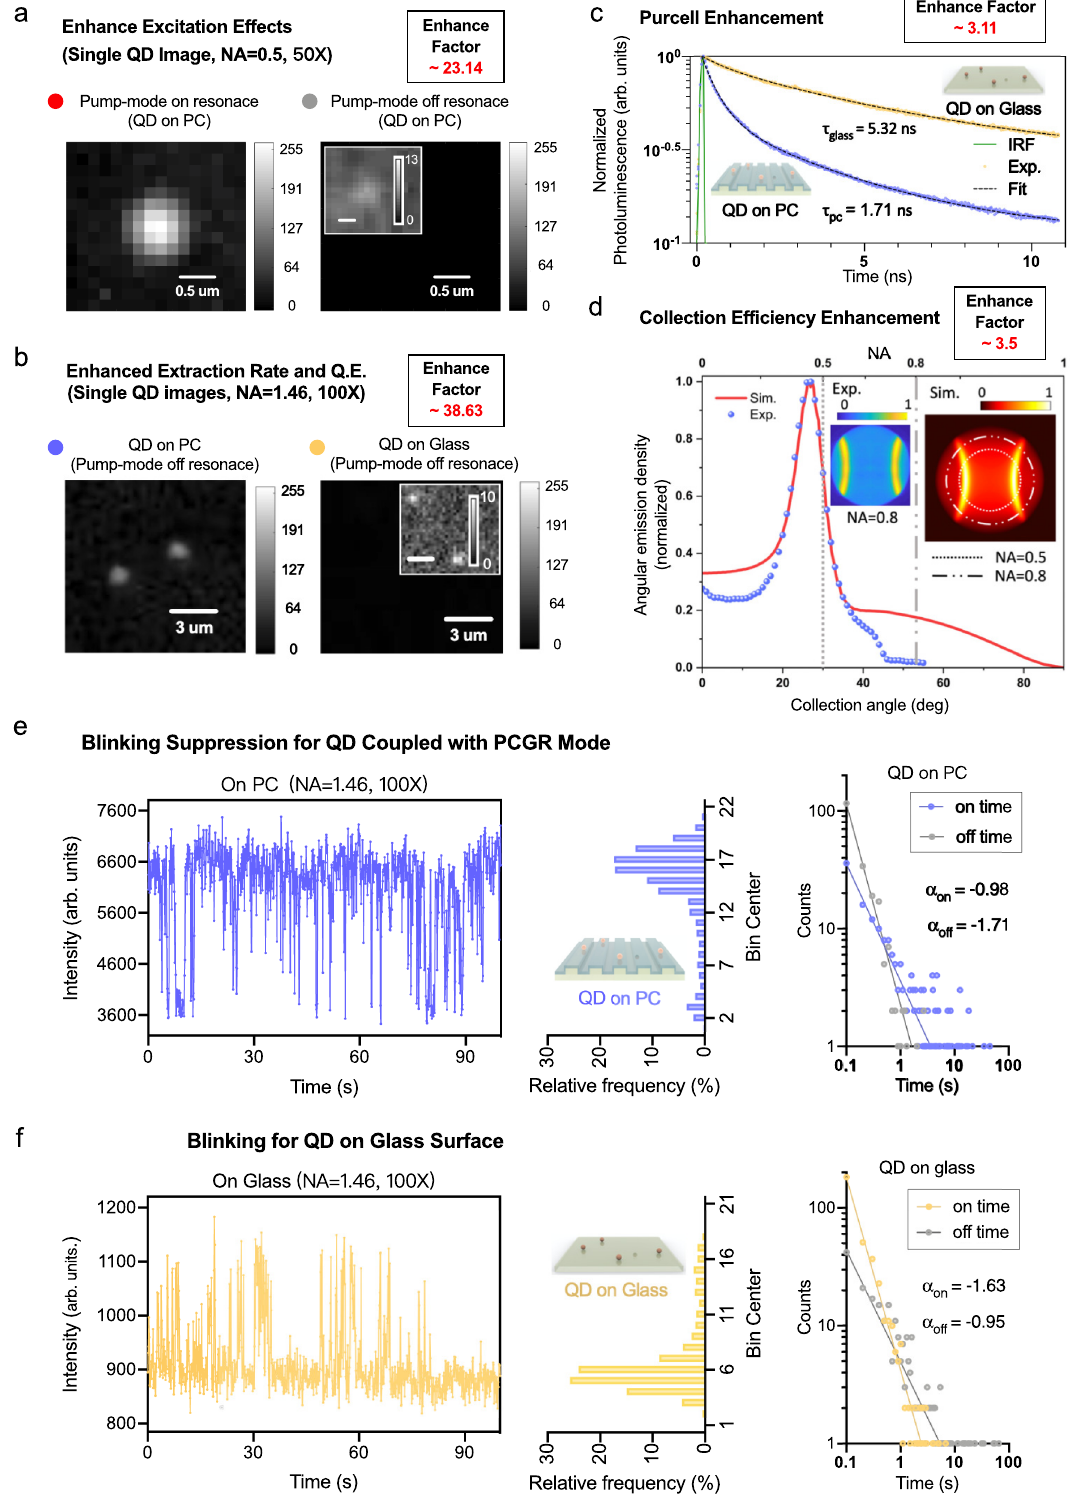
bar) and numerical simulated (red color bar) as double hyperbola- shape bands. The blue dots in the main fi gure show the experimen- tally measured normalized power distribution as a function of both collection angle and numerical aperture limits. The red trace in Fig. 3d con fi rms that the numerical simulation agrees remarkably well with the experimental data. The QD-605 emission (FWHM= 28 nm, see Supplementary Information) is mainly con fi ned in two lobes